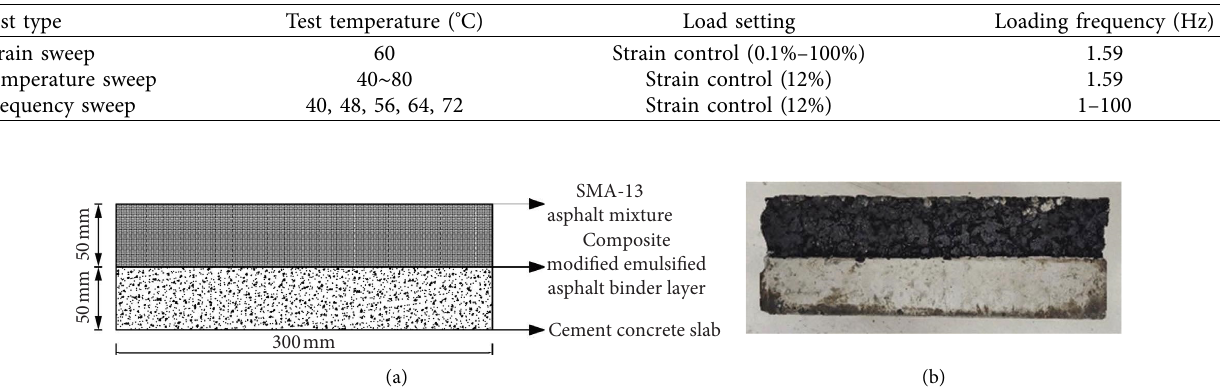
Table 8: Rheological parameter